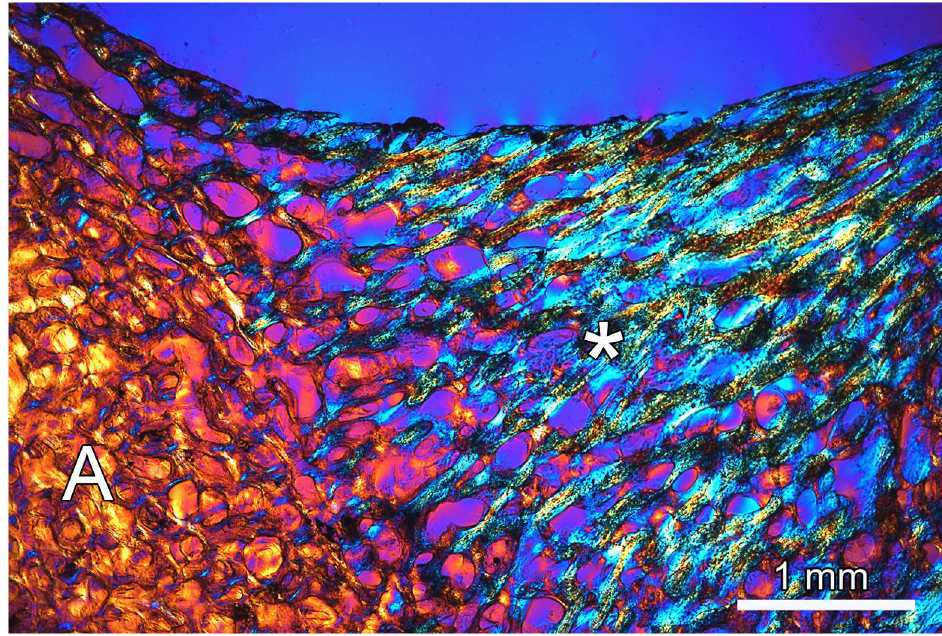
Fig 5. Micrograph of ground section, showing the basal region of the smaller exostosis (asterisk) on the left antler of the white-tailed buck ( Odocoileus virginianus ) (for location see Fig 1) and the underlying antler bone (A). Linearlypolarized light plus full wave retardationplate. Note the changein collagenfiber orientationbetweenthe two portions as evidencedby the interferencecolors, and the continuity of the cancellousbone of the exostosis with that of the antler bone.